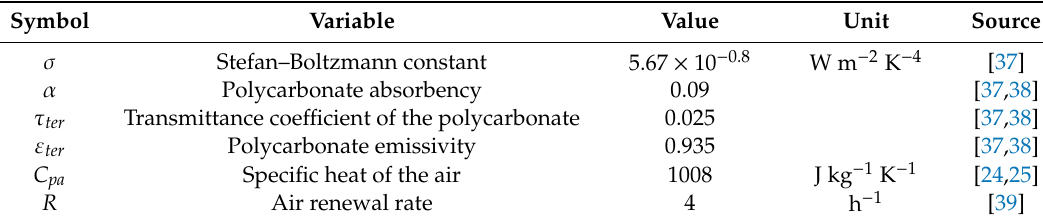
Table 1. Variables for the heat calculation obtained from the literature.